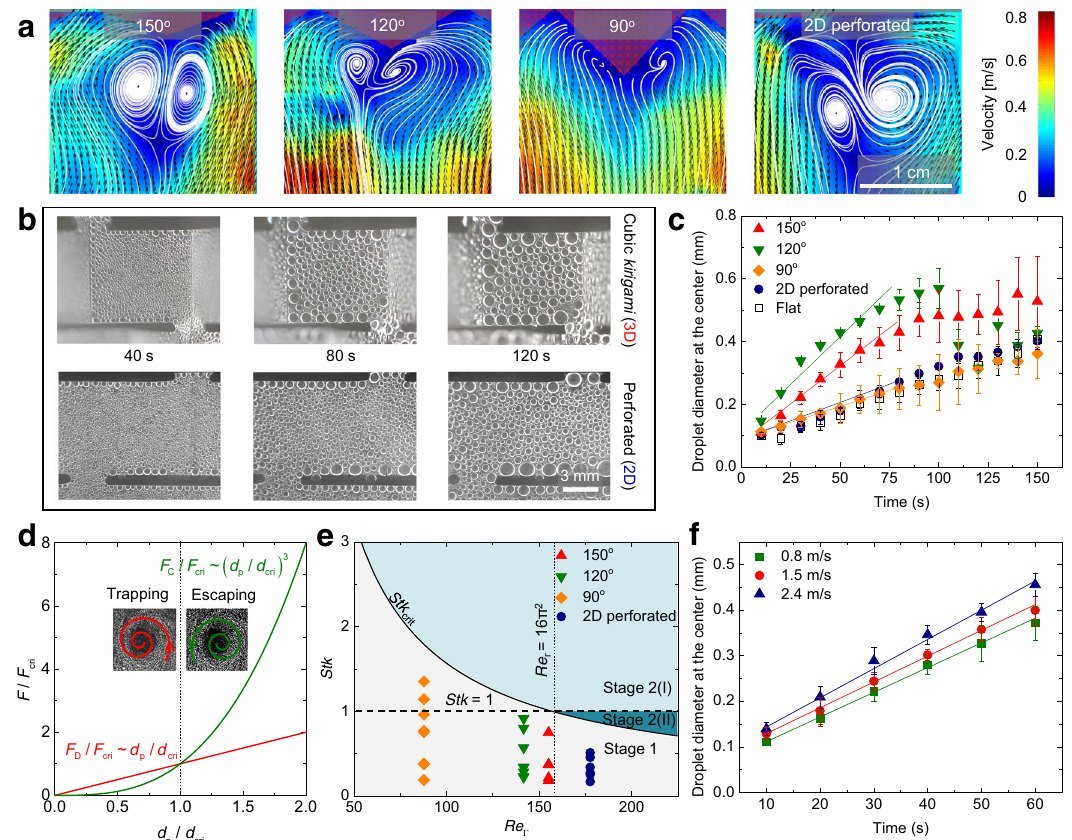
Fig. 2 Origin of the fast fog capture provided by the kirigami -enabled vortices. a The velocity fi eld of fog-laden air around the cubic kirigami surfaces with varying θ . A counter-rotating vortex pair is visualized by streamlines near the substrate, with their positions approaching the substrate as θ decreases. b Time-lapsed optical images revealing the droplet growth on one facet of cubic kirigami ( θ = 150°) from the vertical view. c The variation of average diameters of droplets sitting at the center of facet as a function of time. d The variation of normalized drag force ( F D / F crit ) and centrifugal force ( F C / F crit ) as a function of the droplet diameter factor ( d p / d crit ). The critical droplet radius and force are d crit ¼ 12 πμ a δ diagram demonstrating different regimes of droplet motions. The data points show the measured Stk and Re г of the droplets trapped inside the vortex at various θ . All the experimental data lie in the gray region, and are in good agreement with our model: droplets at stage 1 have Stk (cid:4) Stk crit . f The in fl uence of wind speed on the droplet growth rate sitting at the center of the cubic kirigami ( θ = 150°). Data in ( c , f ) are means ± s.d. of three measurements. In ( a – e ), the wind speed is kept at 0.8